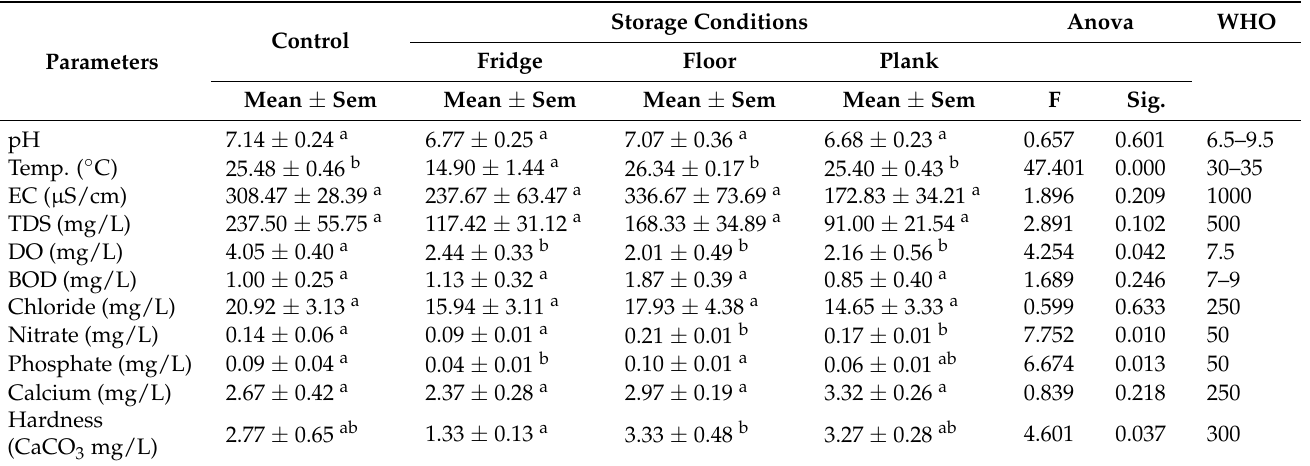
Table 1. Descriptive statistical analysis of physicochemical parameters and microbial quality of sachet water subjected to different storage conditions.